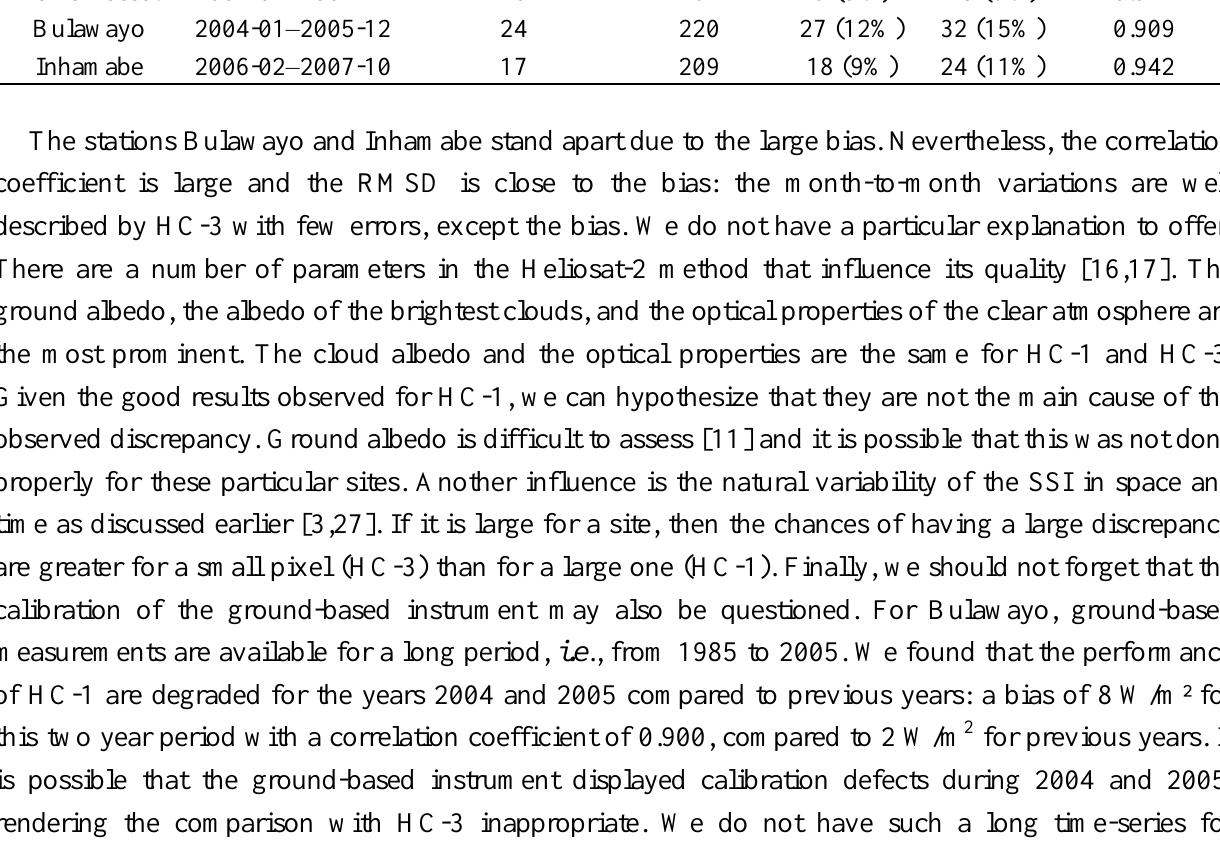
Correlation (relative)